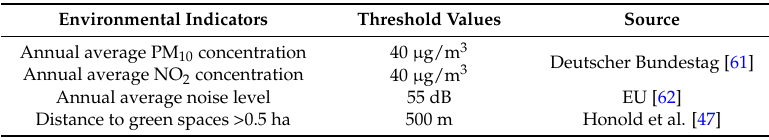
Table 8. Environmental standards used to normalize each environmental